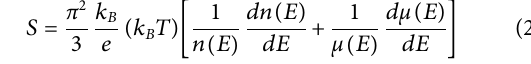
Frontiers in Physics |